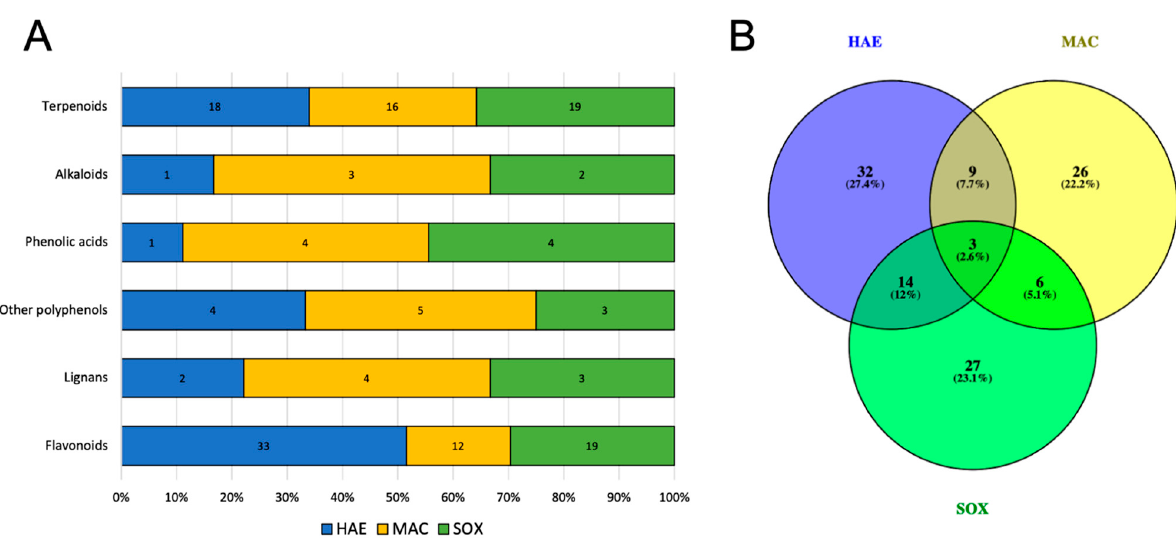
Figure 2. The number, cumulation in classes of compounds, and differences among three methods of extraction represented using variables importance in projection (VIP) markers carried out from three orthogonal projections to latent structures discriminant analysis (OPLS-DA) models such as homogenizer-assisted extraction (HAE), maceration (MAC), and Soxhlet (SOX). ( A ) A cumulative graph of the most representative VIP markers (VIP score > 1.2) resulting from the three OPLS-DA models, according to their compound’s classification. The number reported in the bar corresponds to the number of VIP markers belonging to compounds classes, while the bar color represents the different OPLS-DA models: HAE (blue), MAC (yellow), and SOX (green). ( B ) Venn analysis of three lists of VIP markers resulting from OPLS-DA models.